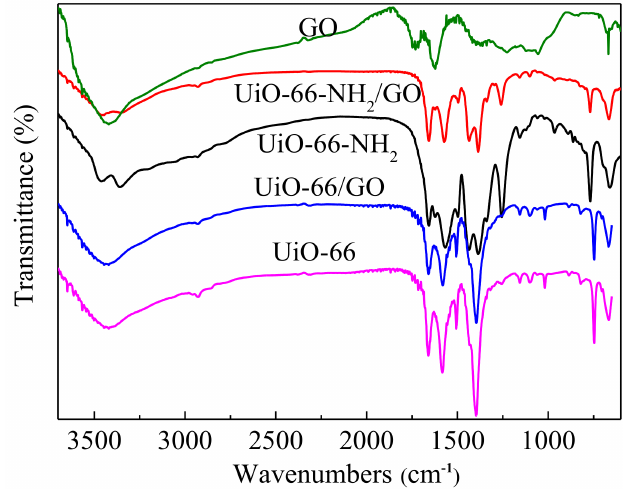
Figure 5. FT-IR spectra of the different